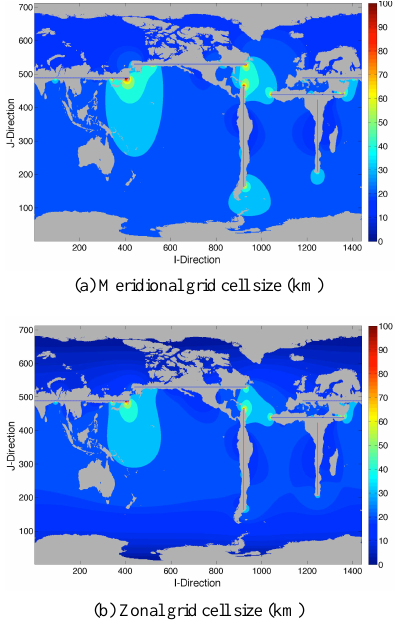
Figure 13. Meridional and zonal grid step sizes in grid space.